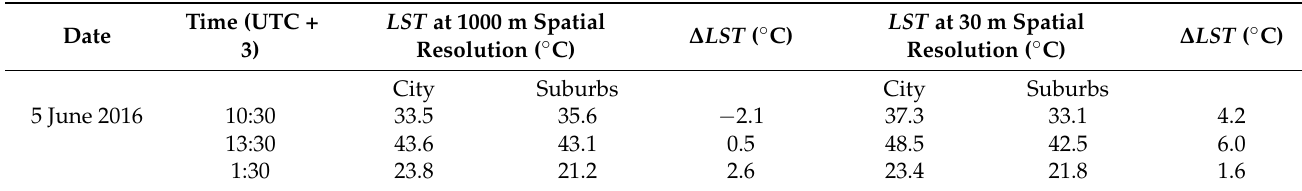
Table 10. Summary of the average values and standard deviation of weather data, clothing insula- tion and the age of the respondents for the comfort values of the questionnaires.